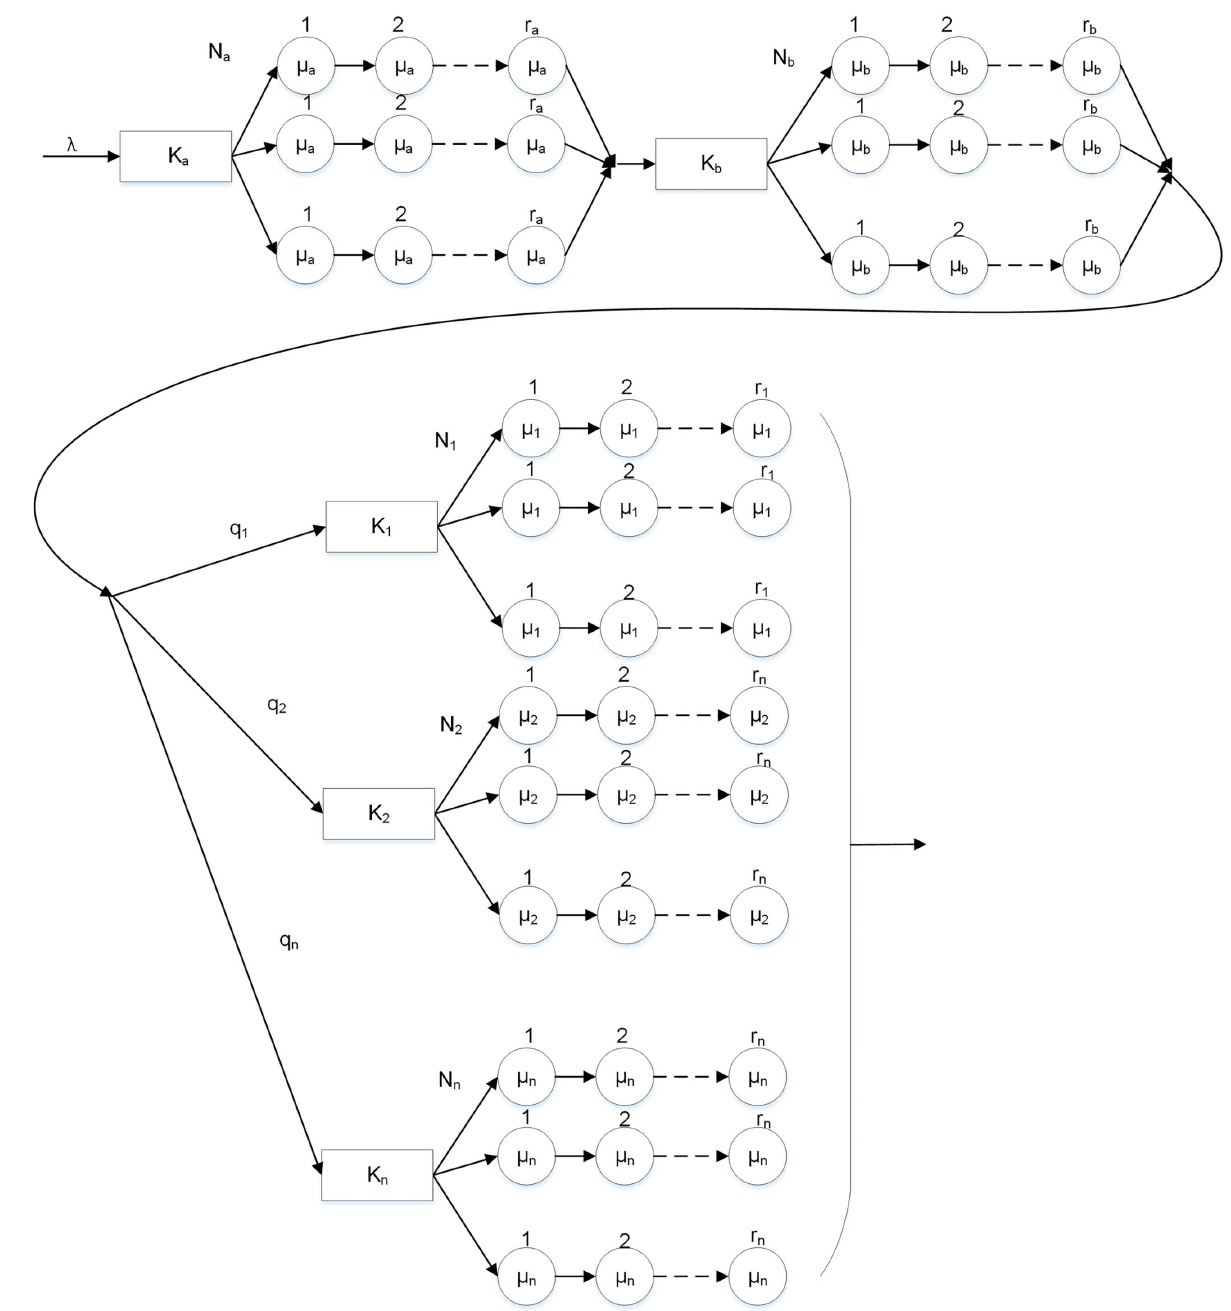
Fig 1. Application layer firewall (ALF)